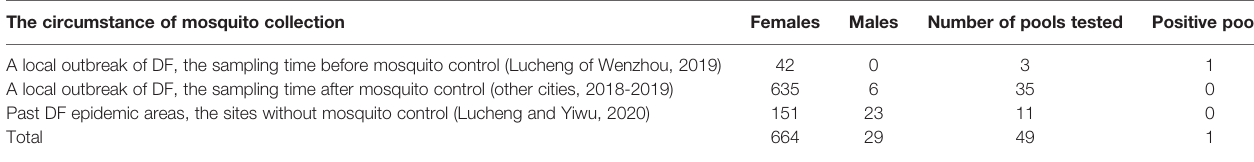
TABLE 1 | The three circumstances of Ae. albopictus collection in Zhejiang province during the 2018 – 2020 dengue outbreak. The circumstance of mosquito collection Females Positive